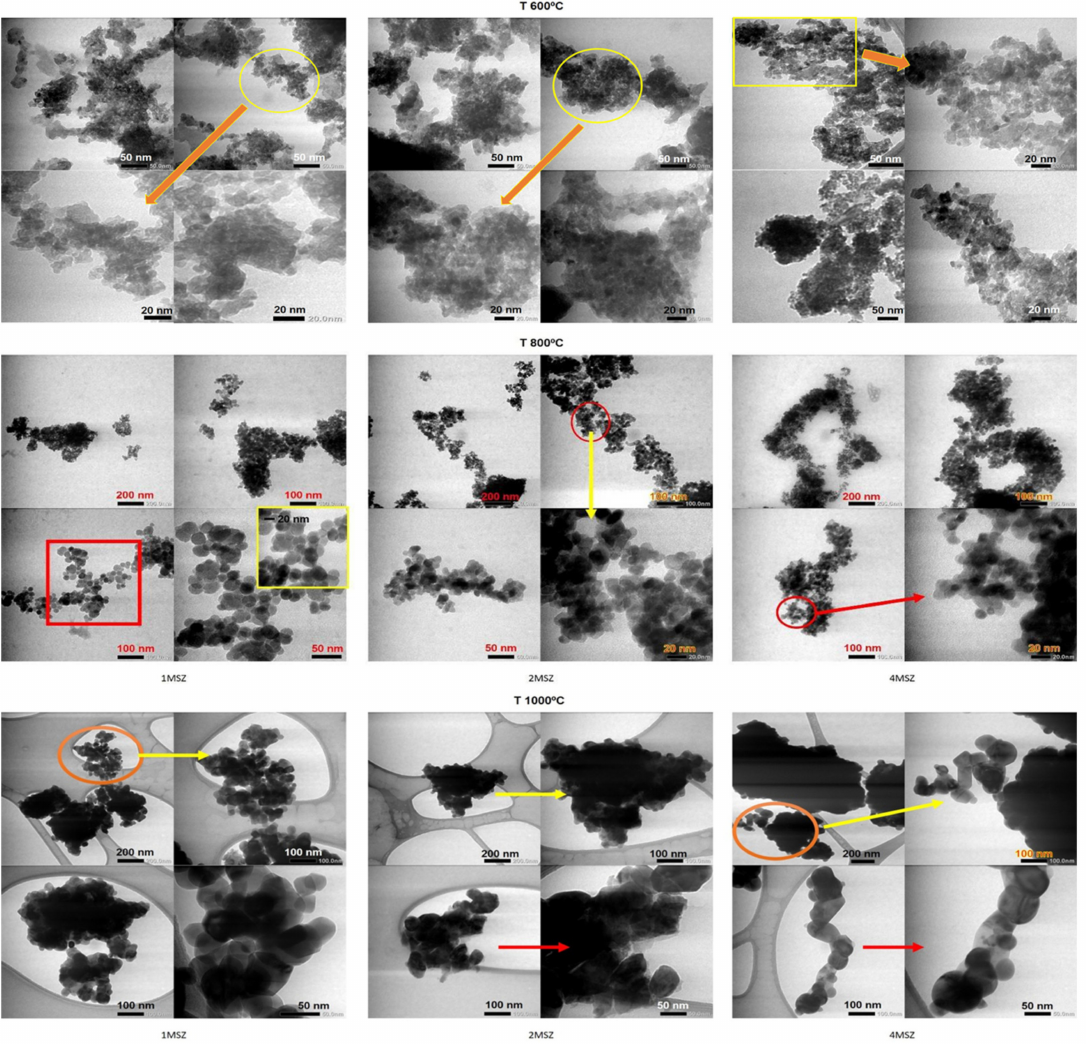
Figure 5. TEM images of MSZ samples calcined at 600 ◦ C, 800 ◦ C and 1000 ◦